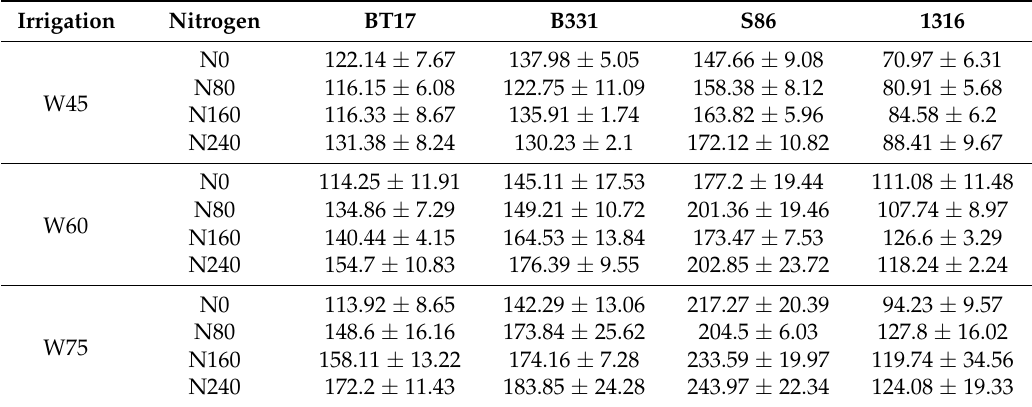
Table 2. Stand volume increment of four Populus tomentosa clones in October 2014 in relation to irrigation and nitrogen application since 2007. W45, W60, and W75 indicate plots in which the soil water contents were maintained at 45%, 60%, and 75% above field capacity, respectively. N0, N80, N160, and N240 indicate plots in which 0, 80, 160, and 240 g nitrogen per plant, respectively, was applied. Means and standard errors are shown (n = 3).